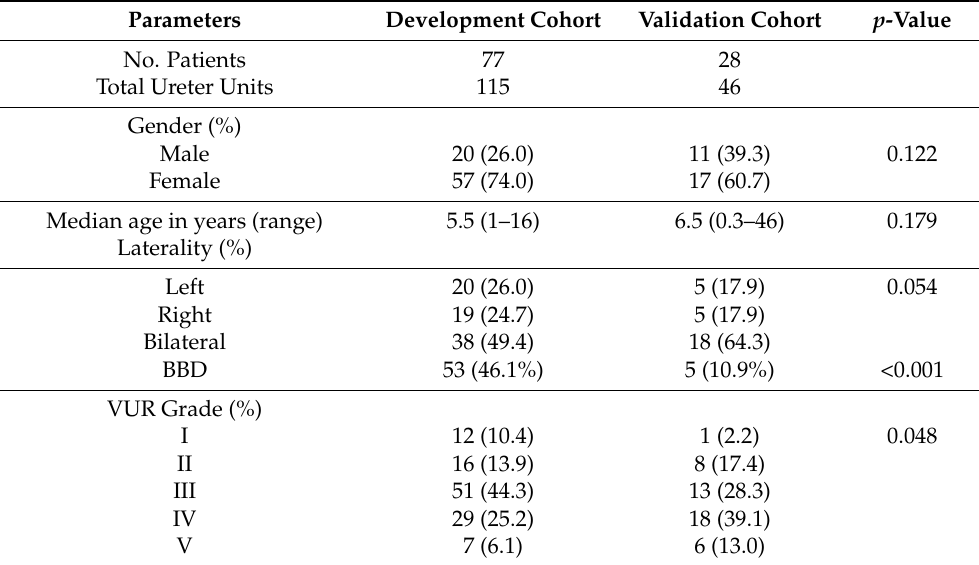
Table 1. Patient demographics and pre-operative